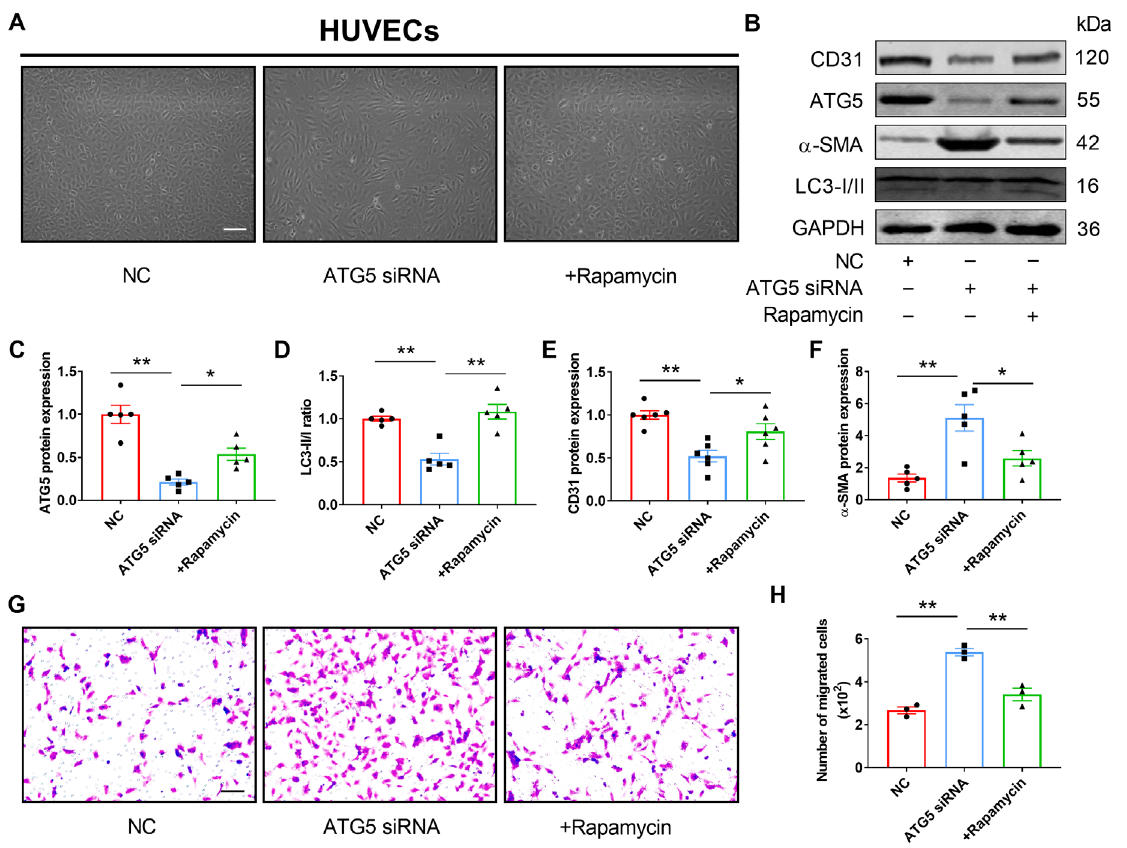
Figure 4. Inhibition of autophagy induces EndMT in HUVECs. ( A ) Morphological changes post the indicated treatments were observed under the microscope (scale bar indicates 100 µ m) ( n = 3). ( B – F ) ATG5, CD31, and α -SMA protein expressions and the LC3-II/LC3-I ratio were detected using Western blotting. Fold changes are shown ( n = 5). ( G , H ) Transwell cell invasion assay was performed to analyze the migration ability of cells (scale bar indicates 100 µ m) ( n = 3). The data are presented as the mean ± S.E.M. * p < 0.05, ** p < 0.01.